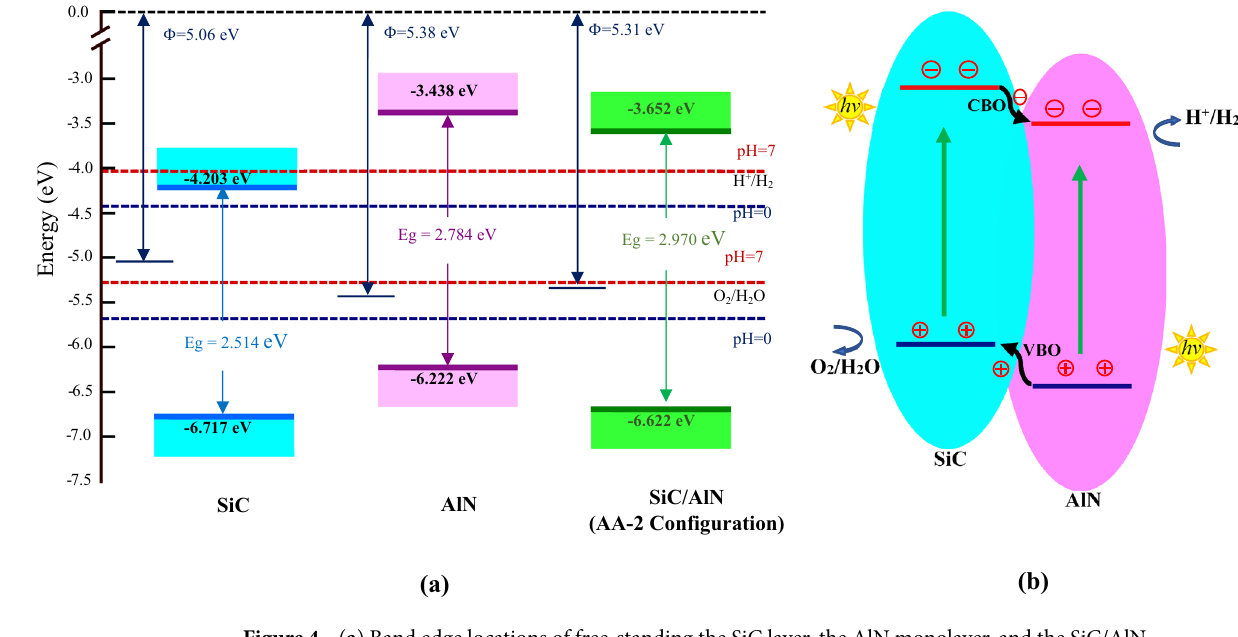
Figure 4. ( a ) Band edge locations of free-standing the SiC layer, the AlN monolayer, and the SiC/AlN heterostructure. ( b ) Schematic illustration of the photocatalytic action of the SiC/AlN van der Waals heterostructure with the transfer of the photogenic carriers at the interface. VBO and CBO refer to the valence band offset and conduction band offset, respectively.